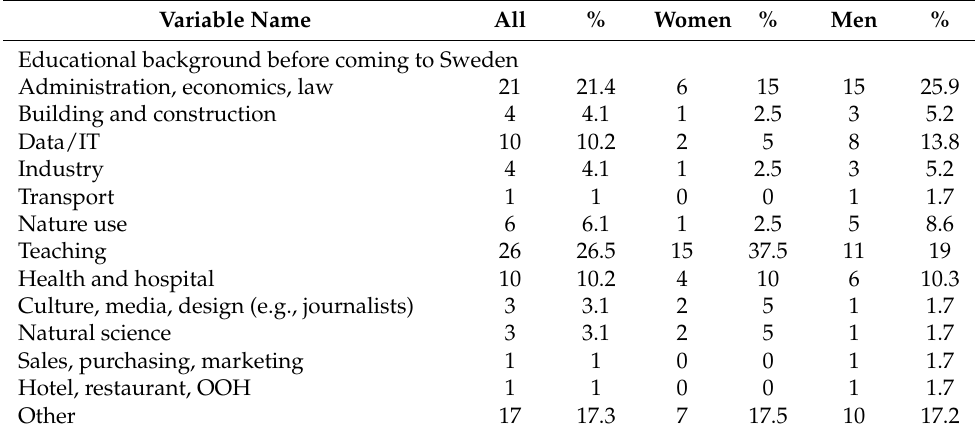
Table A1. Educational background and work experience before coming to Sweden of highly-skilled respondents with refugee experience ( N =